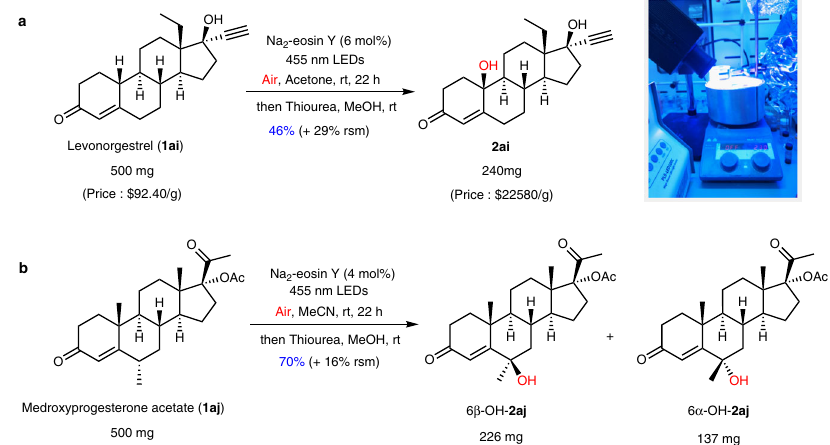
Fig.5|500mg-scalehydroxylationofenoneexamplesatambienttemperature and atmosphere with air asthe oxidant. a Hydroxylationof 1ai on500mg scale. b Hydroxylation of 1aj on 500mg scale. See the Supplementary Information for